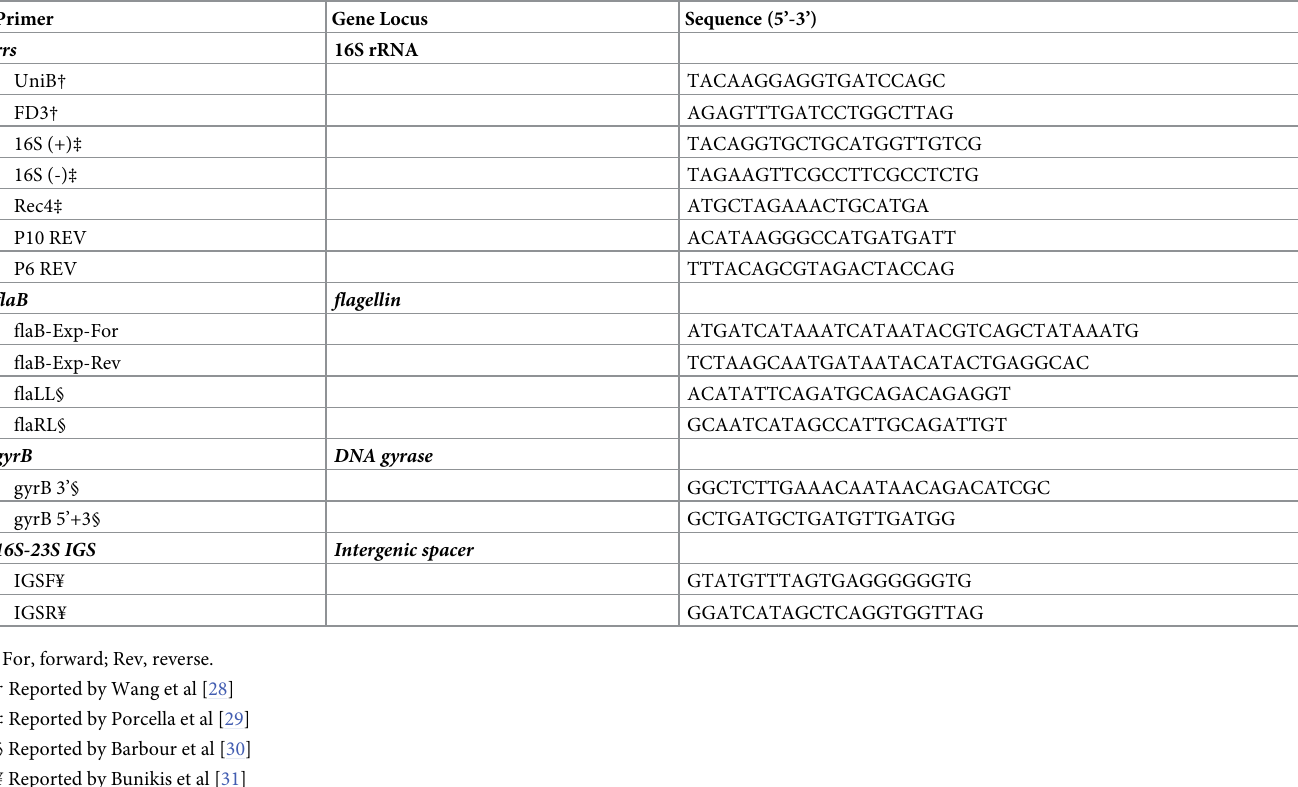
Table 2. Oligonucleotides used for PCR and MLST of relapsing fever spirochetes, Texas, USA � .